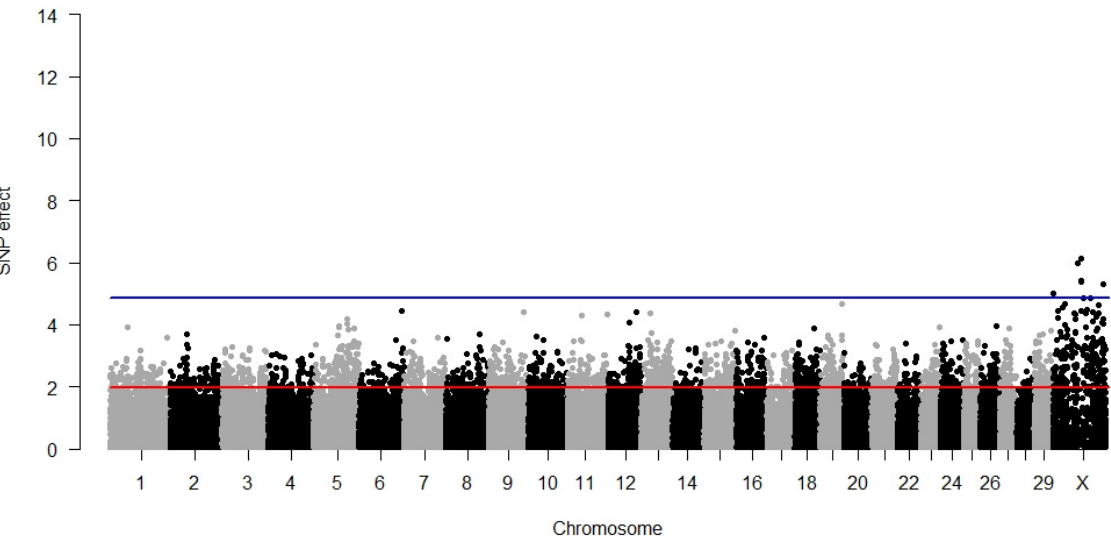
Figure 5. GWAS results for temperament. The red line (1.96) represents a nominal and the blue line (4.88) a Bonferroni-corrected critical value corresponding with a 5% significance (4.88) a Bonferroni ‐ corrected critical value corresponding with a 5% significance level.